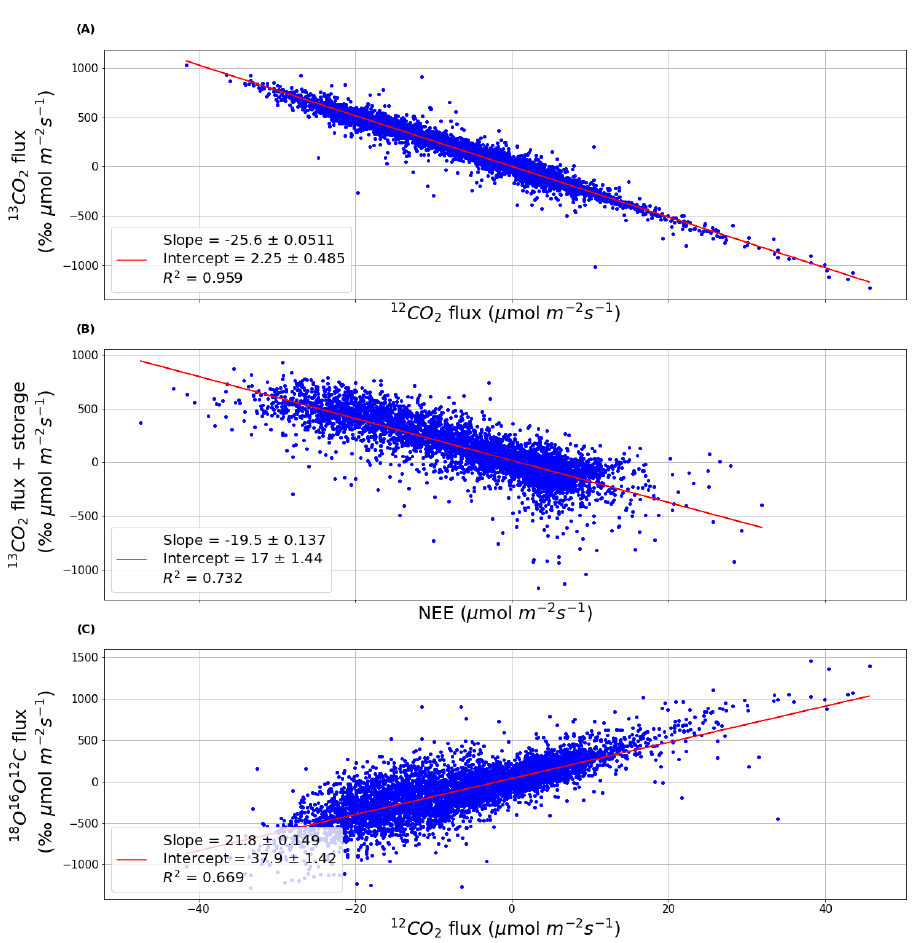
Figure 4. CO 2 isotopocule data, ( A ) shows the non-gap filled 13 C 16 O 2 data plotted against NEE determined using 12 C 16 O 2 data (“hf209-10” dataset) between April and October from 2011 to 2013; ( B ) shows 13 C 16 O 2 data aggregated to be plotted against NEE from the “US-Ha1 28-years” dataset; ( C ) shows the non-gap filled 18 O 12 C 16 O data plotted against NEE 12 C 16 O 2 non-gap filled